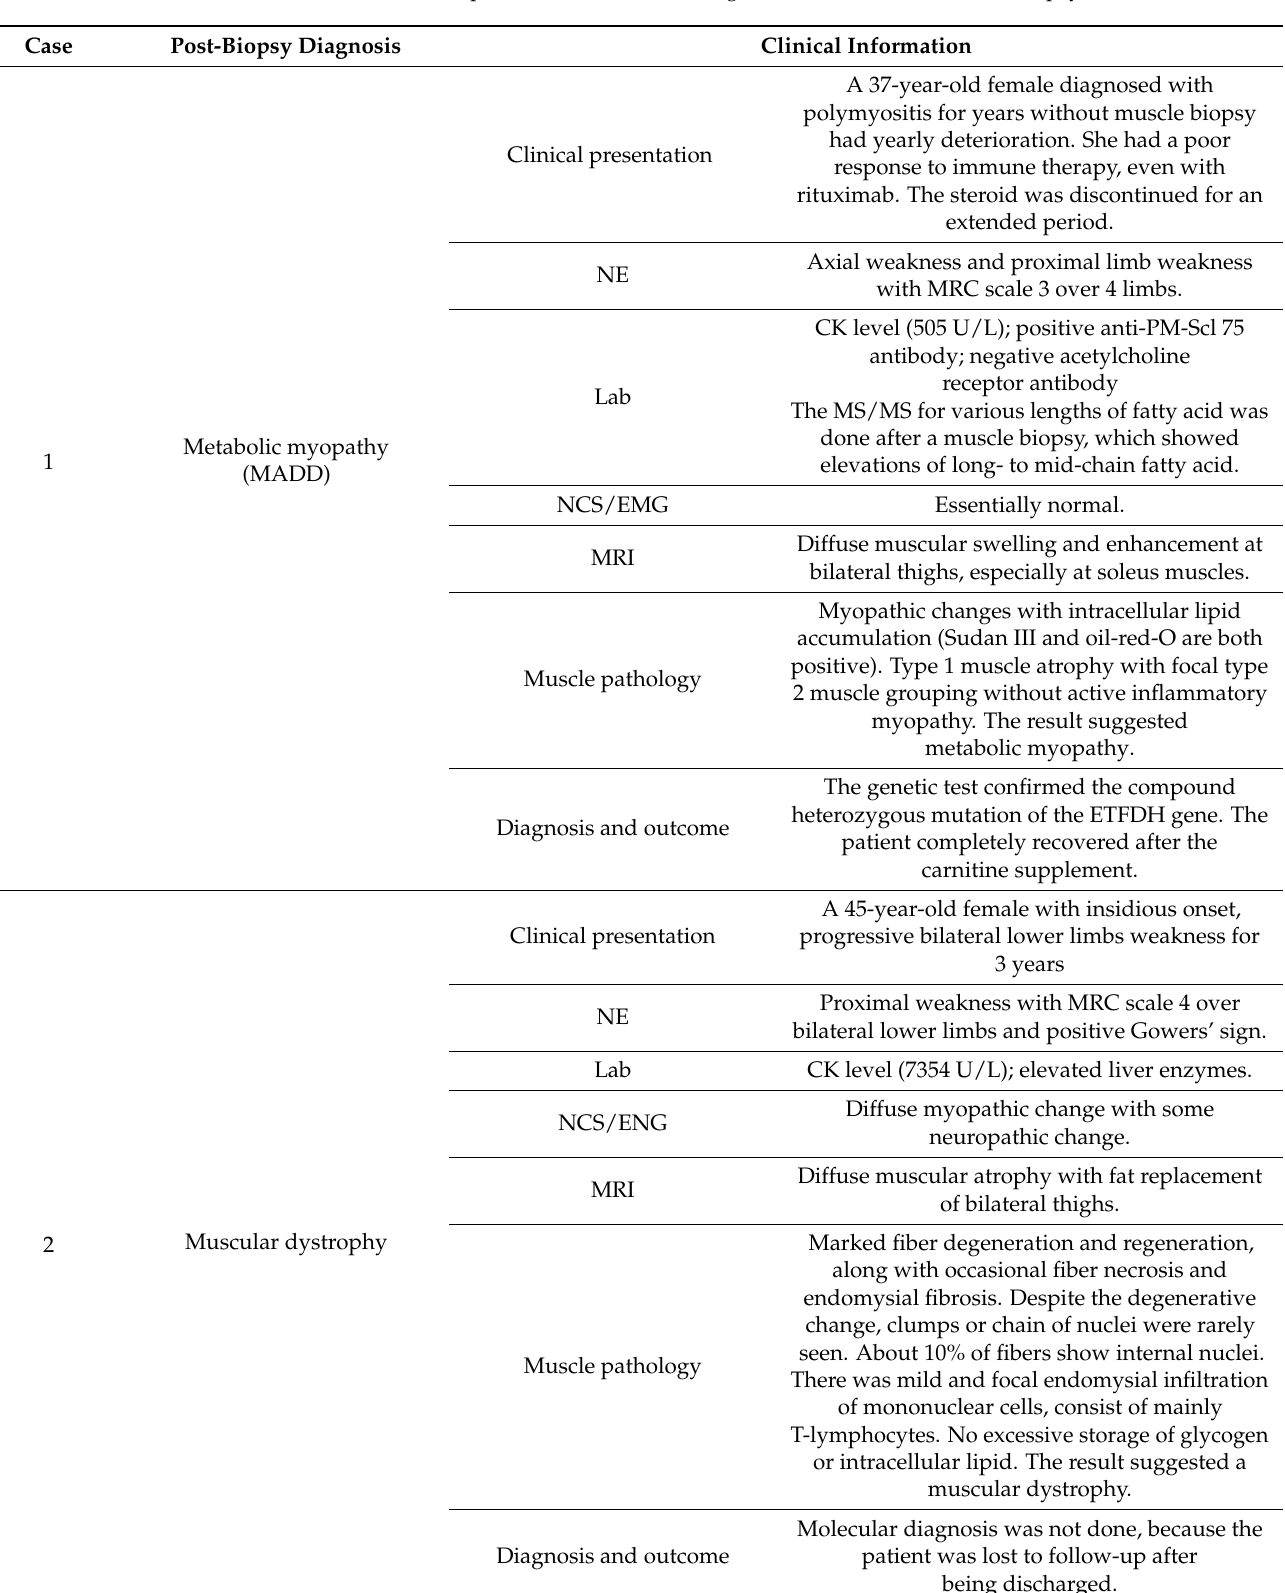
Table 2. A list of patients who were misdiagnosed as IIM before muscle